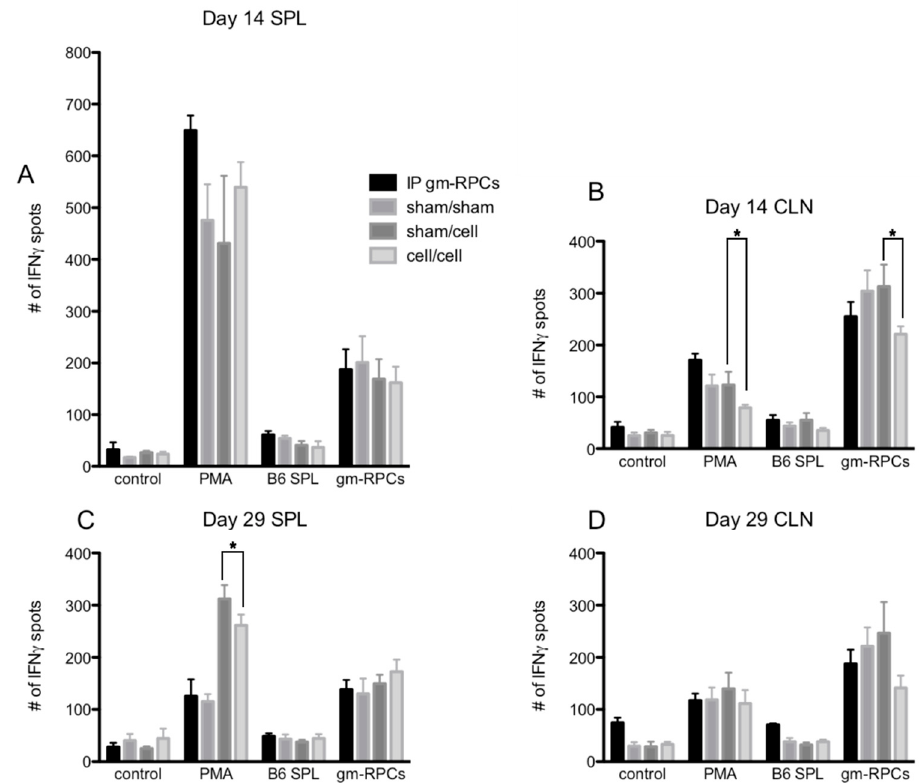
Figure 4. ELISPOT quantification following gmRPC transplantation. ELISPOT assays were setup as the following groups: control, responder cells alone (lymphocytes or splenocytes containing T cells isolated from cervical lymph nodes (CLNs) or spleens (SPL) of the experimental animals; PMA, responder cells treated with phorbol 12-myristate 13-acetate (PMA) and Ca ionophore; B6 SPL, responder cells mixed with splenocytes isolated from C57BL/6 animals; gmRPCs, the same responder cells mixed with gmRPCs. ( A ), The responder cells were the splenocytes from the experimental animals that were sacrificed at day 14 after the second gmRPCs injection. ( B ) The responder cells were the lymphocytes from the CLNs of the experimental animals that were sacrificed at day 14 after the second gmRPCs injection. ( C ) The responder cells were the splenocytes from the experimental animals that were sacrificed at day 29 after the second gmRPCs injection. ( D ) The responder cells were the lymphocytes from the CLNs of the experimental animals that were sacrificed at day 29 after the second gmRPCs injection. Two-way ANOVA tests were used to test significance (*) between the sham/cell and cell/cell groups; p values were: ( A ) p < 0.5332, ( B ) p < 0.0001 (significant), ( C ) p < 0.0207 (signi fi cant), and ( D ) p < 0.3355.